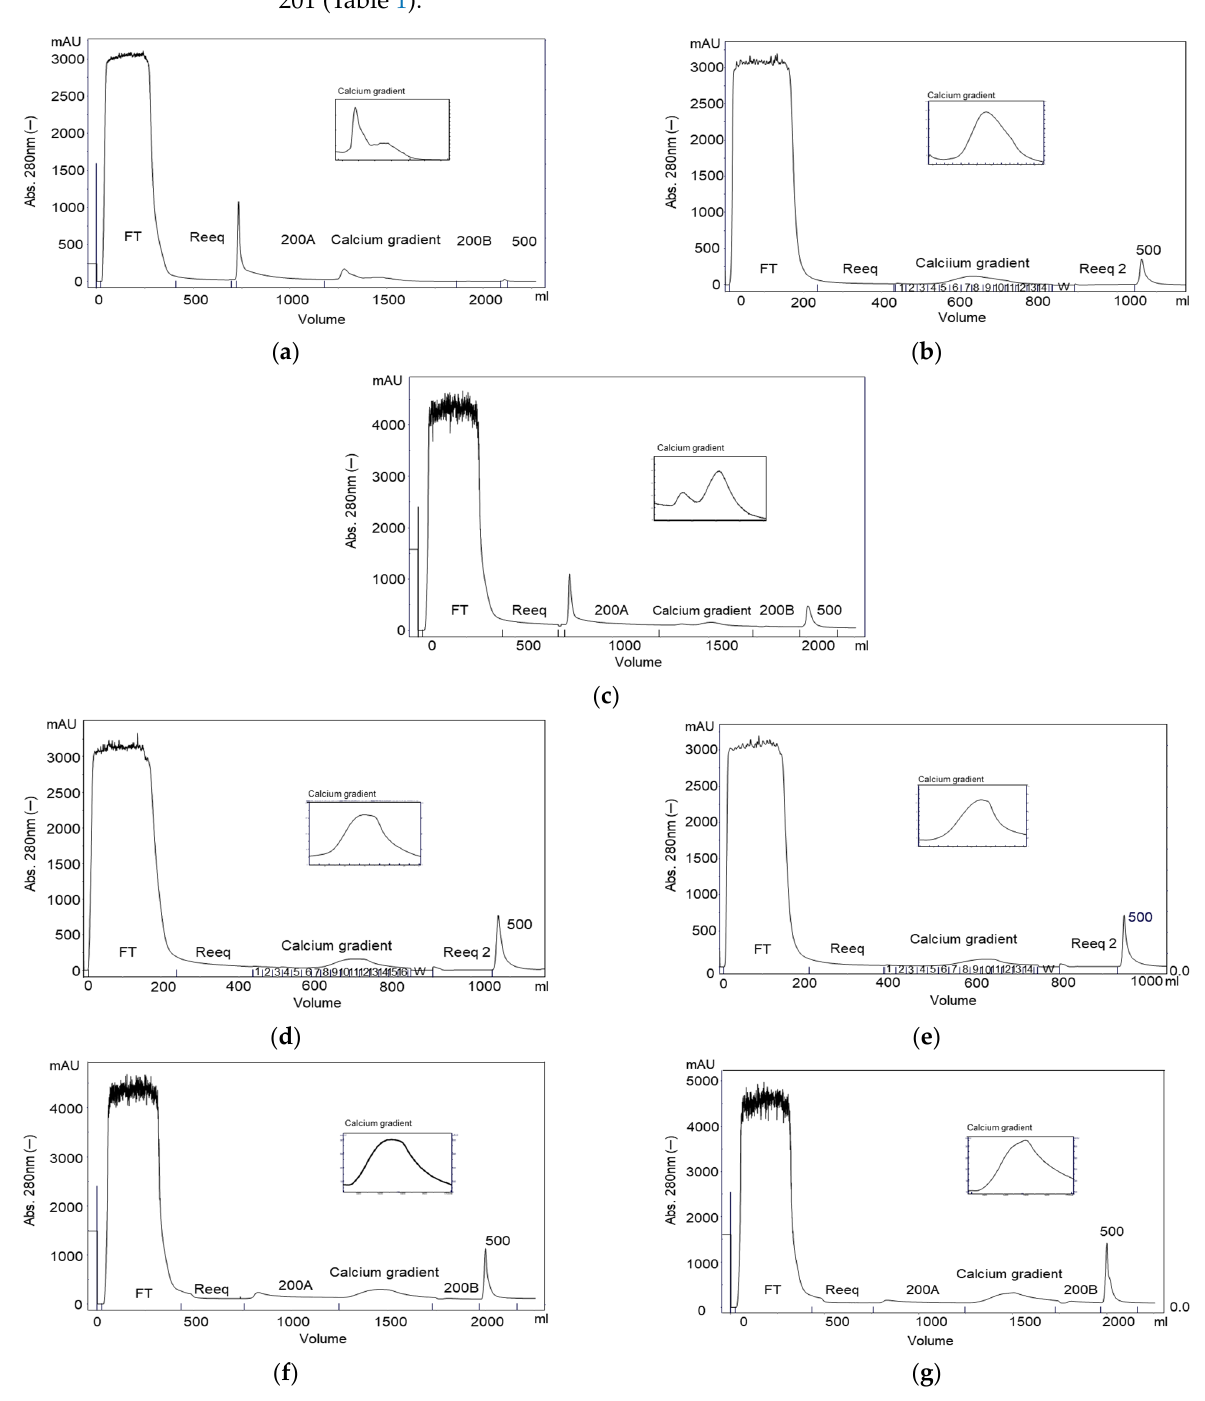
Figure 1. Chromatograms of the purifications of plasma on: ( a ) Q Sepharose FF with 5 mM to 100 mM linear CaCl 2 gradient and citrate buffer; ( b ) Fractogel EMD TMAE with 5 to 50 mM linear CaCl 2 gradient and citrate buffer; ( c ) ANX Sepharose FF, 5 to 25 mM linear CaCl 2 gradient and citrate buffer; ( d ) DEAE Sepharose FF, 5 to 50 mM linear CaCl 2 gradient and citrate buffer; ( e ) Fractogel EMD DEAE, 5 to 50 mM linear CaCl 2 gradient and citrate buffer; ( f ) ANX Sepharose FF, 5 to 25 mM linear CaCl 2 gradient and Bis-tris buffer; and ( g ) ANX Sepharose FF, 5 to 25 mM linear CaCl 2 gradient and MES